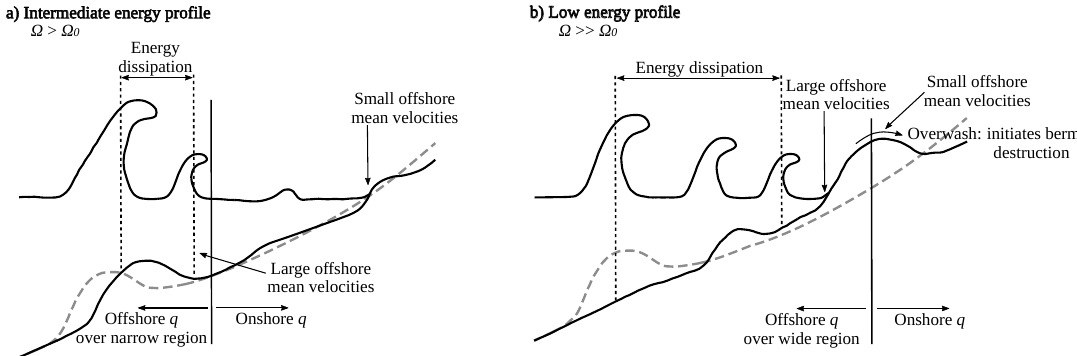
Figure 10. Conceptual model summarising morphodynamics of equilibrium profile evolution for the same incident wave condition and two significantly different initial morphologies. ( a ) Intermediate energy profile; ( b ) Low energy profile. Dashed grey lines present the equilibrium profile towards which the beach